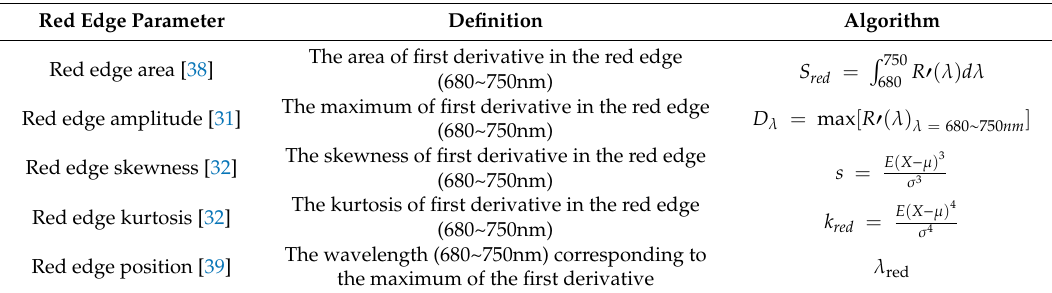
Table 1. Definition and algorithm of red edge